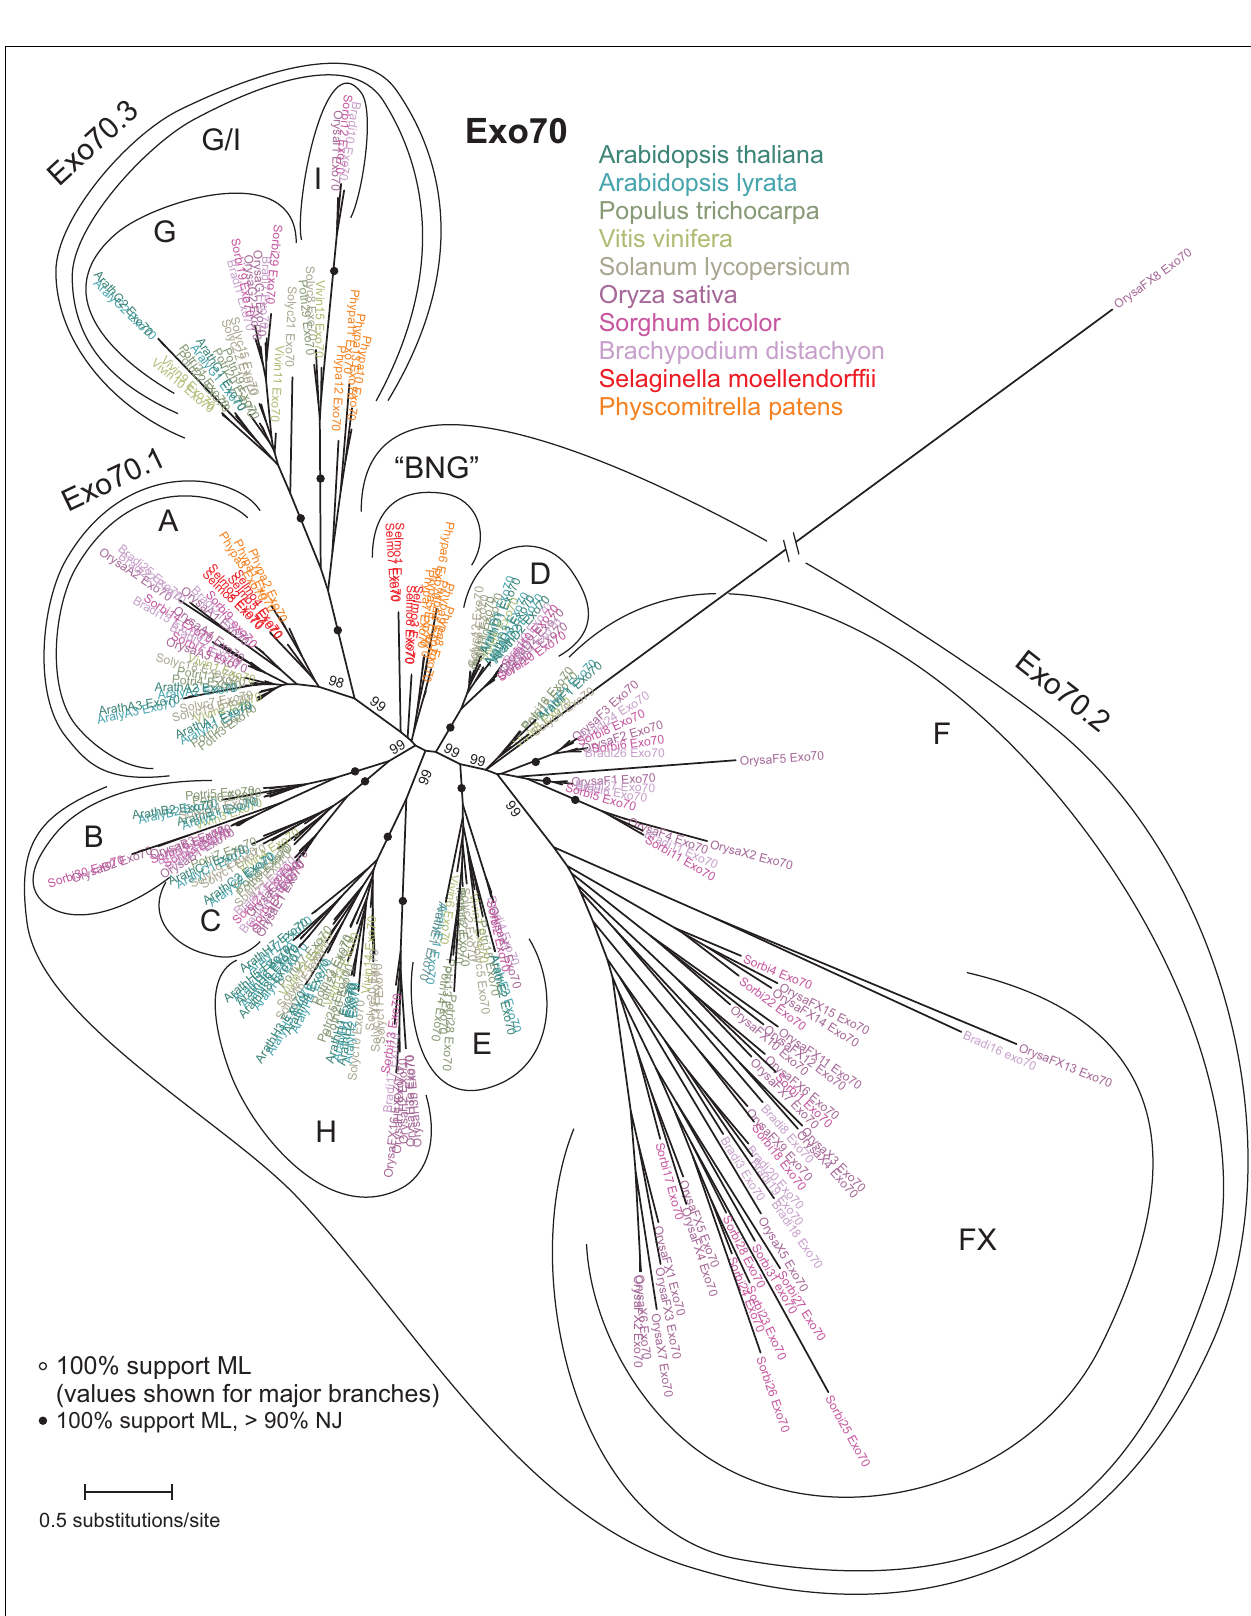
Frontiers in Plant Science | PlantTraffic